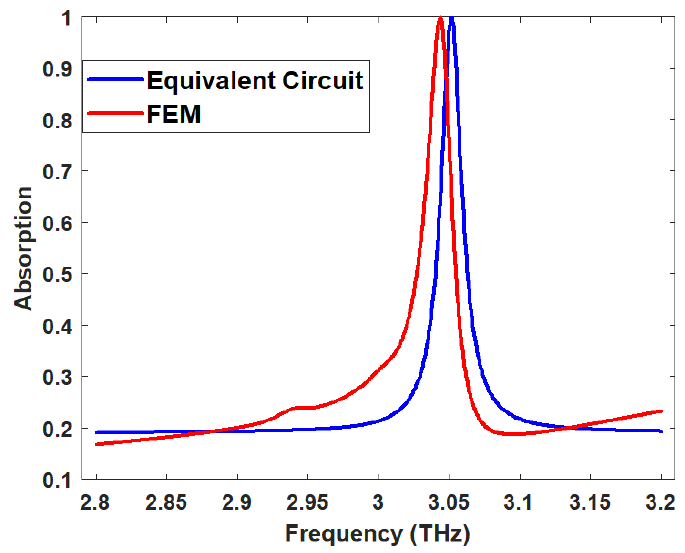
Figure 13. Comparison of Equivalent circuit and FEM method of the proposed absorber.